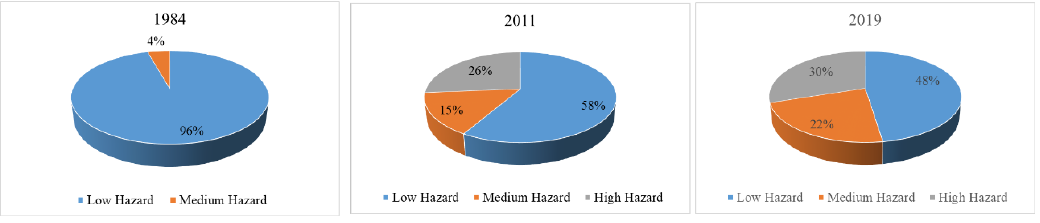
Figure 18. The percentage of exposed areas for the flood hazard levels over time from 1984 to 2019 in Drunka.